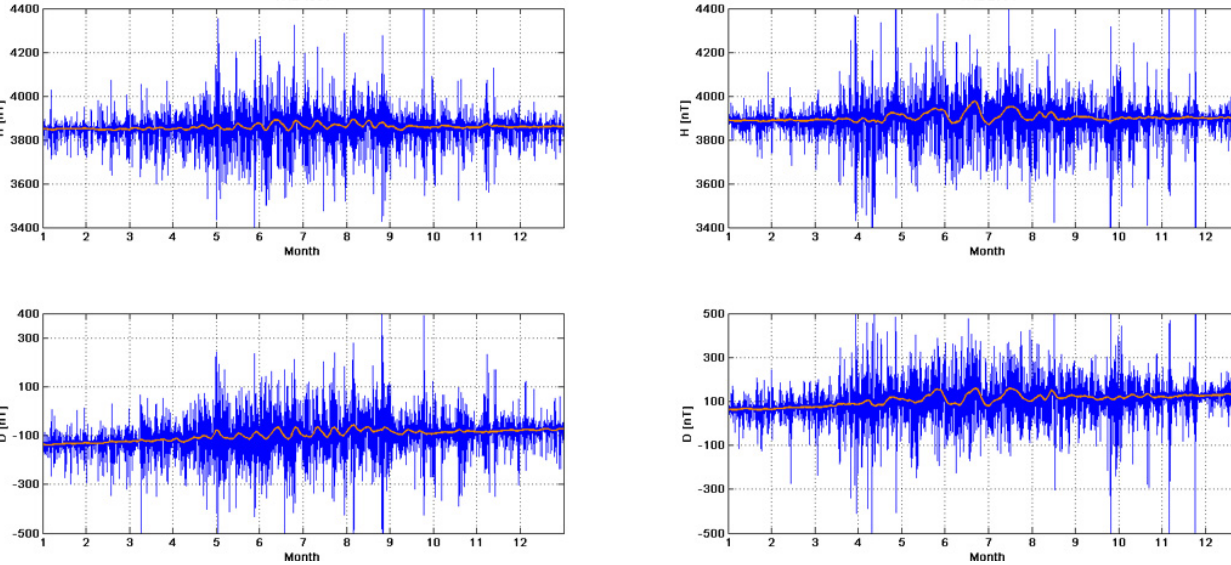
Fig. 3. The SS effect, displayed by the method of filtration with the 7-day averaging window and nonlinear smoothing (yellow line) and the original data series of the ground magnetic D and H variations observed at station Thule (blue lines) for 1998 and